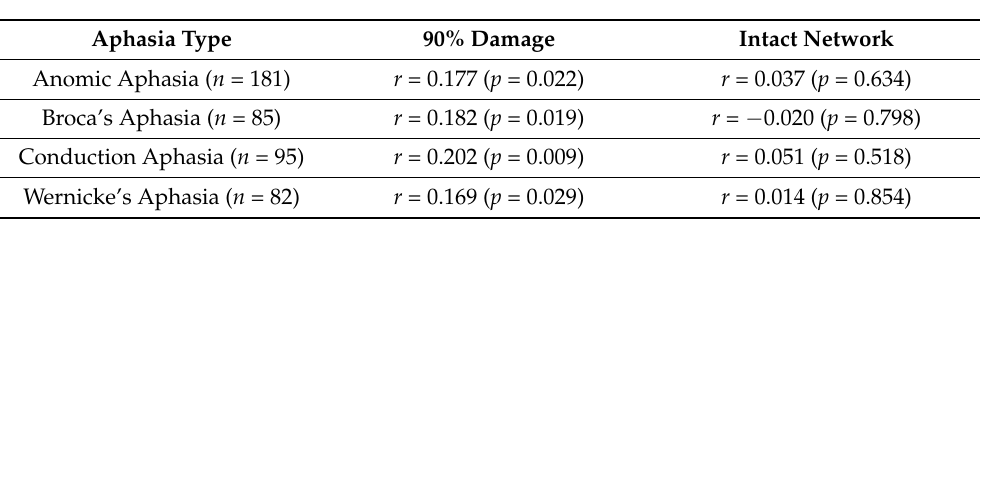
Table 2. Pearson correlations between simulation activation level in the network with 90% damage and naming accuracy across types of aphasia, and between simulation activation level in the intact network and naming accuracy across types of